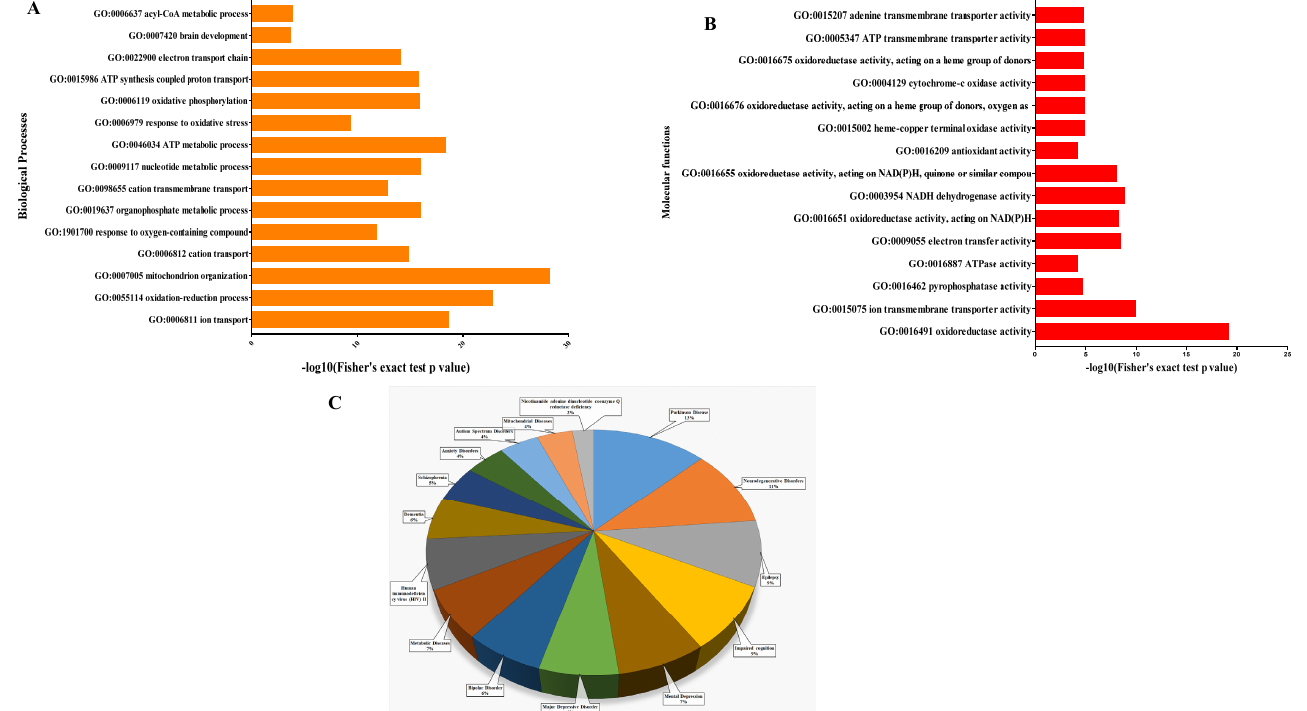
Figure 5. Functional analysis of protein. ( A ) Biological process identification was carried out by the PANTHER classification system, and Gene Ontology (GO) terms were retrieved. The top 15 significantly ( p ≤ 0.05) enriched GO terms in the biological process category are shown. ( B ) Molecular function identification was carried out by the PANTHER classification system, and Gene Ontology (GO) terms were retrieved. The top 15 significantly ( p ≤ 0.05) enriched GO terms in molecular functions are shown. ( C ) OMIM MedGen databases were used to identify the most significant ( p ≤ 0.05) diseases associated with altered proteins and are shown in a circular